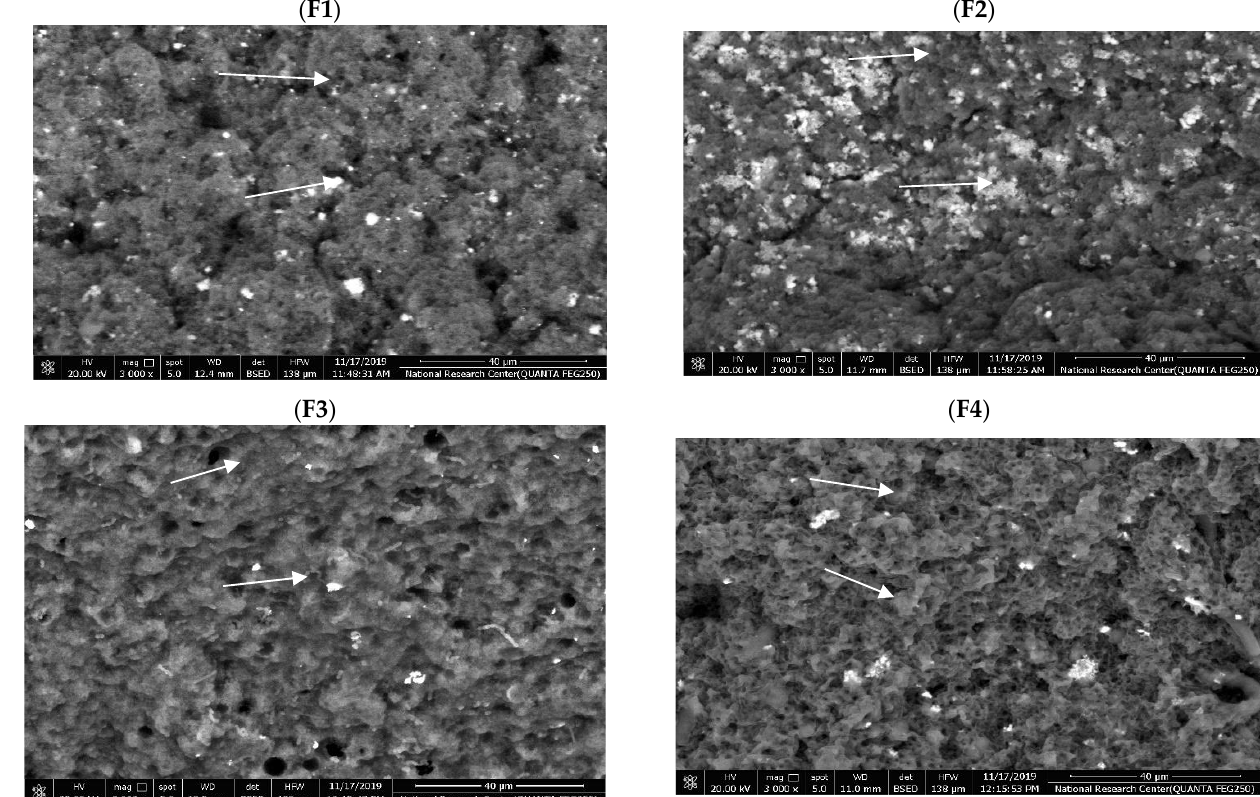
Figure 3. Scanning electron microscopy images of probiotic-frozen yogurt, F1: Control frozen yogurt; F2: Frozen yogurt with stevia; F3: Frozen yogurt with sucralose; F4: Frozen yogurt with sorbitol; The white arrows show the pores size and structure of samples.